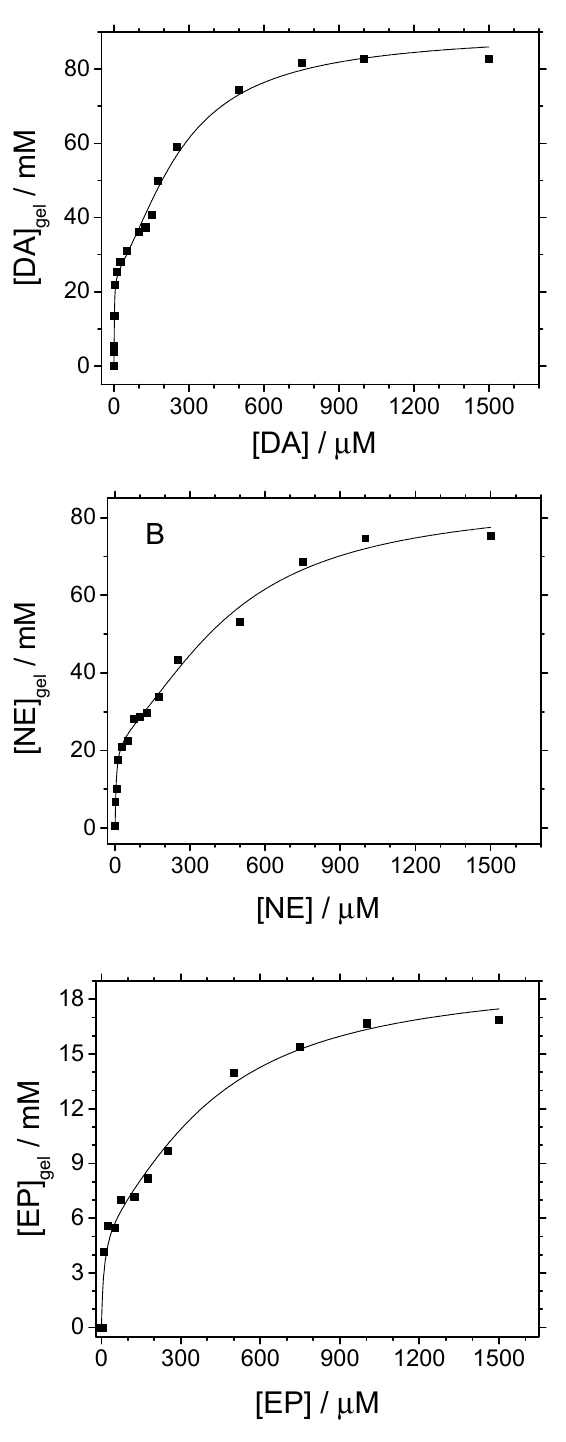
Figure 7. Neurotransmitters adsorption isotherms determined for silica-modified GC electrodes in PBS solutions, pH 7. Equilibration time was 10 min in all cases. T = 25 °C. Table 2. Calculated parameters for the adsorption isotherms of neurotransmitters: concentration of neurotransmitter equivalent to an adsorbed monolayer (cid:4670)𝑁𝑇(cid:4671) (cid:3040) , affinity constant for the formation of a monolayer 𝑘 (cid:3040) , affinity constant for multilayers 𝑘 (cid:3013) , maximum number of adsorbed layers n , and surface coverage 𝜃 (cid:3015)(cid:3021) .